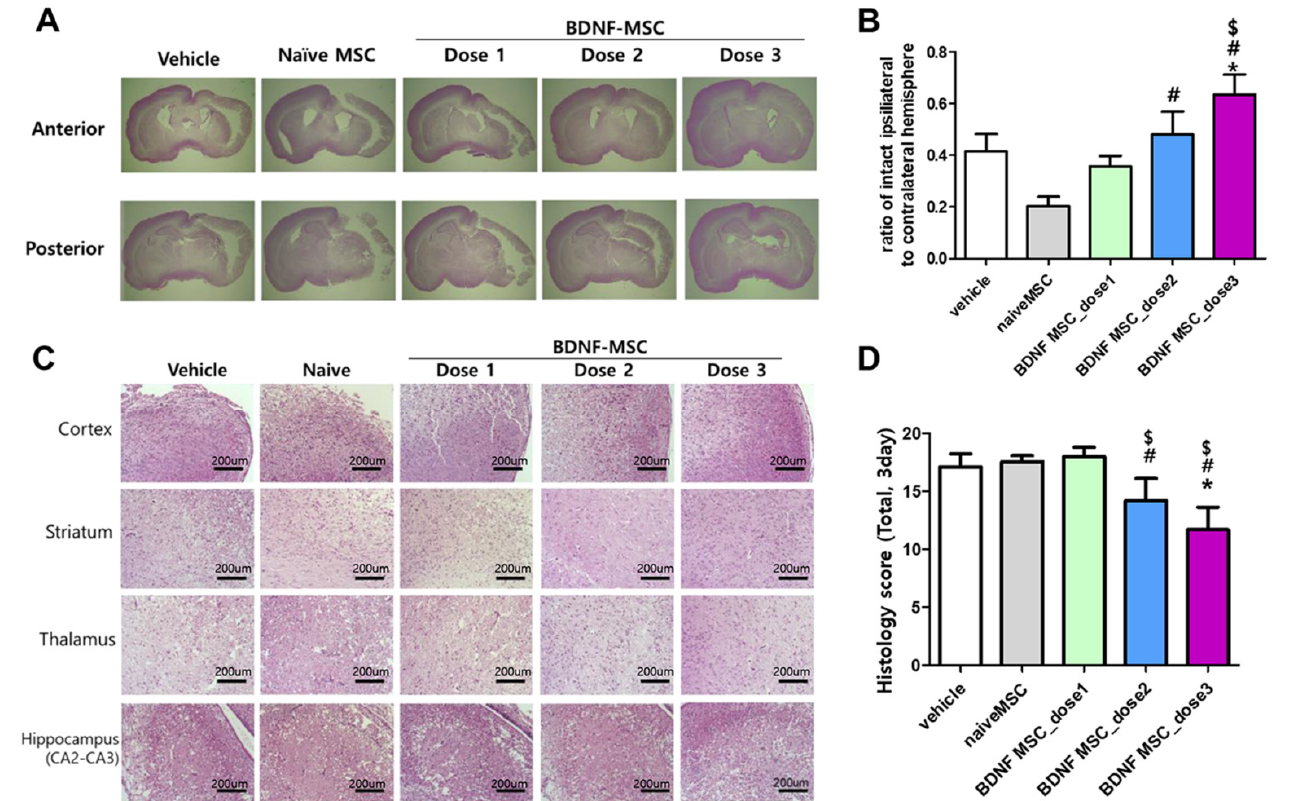
Figure 3. Morphological changes in the brains following hypoxic-ischemic brain injury and MSC transplantation. ( A ) Hematoxylin and eosin (H&E)-stained brain sections showing representative gross morphology of brains at 3 days after modeling. ( B ) The ratio of intact ipsilateral hemisphere to contralateral hemisphere was evaluated in the histologic brain section at 3 days after modeling in each group. ( C ) H&E-stained brain sections showing representative brain histology in cortex, striatum, thalamus, and hippocampus at 3 days after modeling. ( D ) Total sum of histologic scores in each area of brain; cortex, striatum, thalamus, and hippocampus. Data are expressed as mean ± standard error of the mean. * p < 0.05 compared to the HI + vehicle control, # p < 0.05 compared to the HI + naïve MSCs, $ p < 0.05 compared to HI-+ BDNF-eMSCs at dose 1 (approximately 1 × 10 4 cells). Abbreviations: vehicle, HI + vehicle control, naïve MSCs; HI + naïve MSCs,